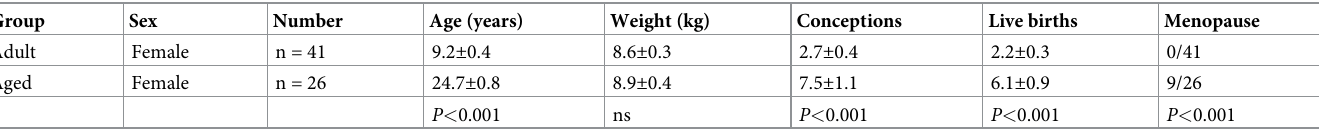
Table 1. Demographic and reproductive history